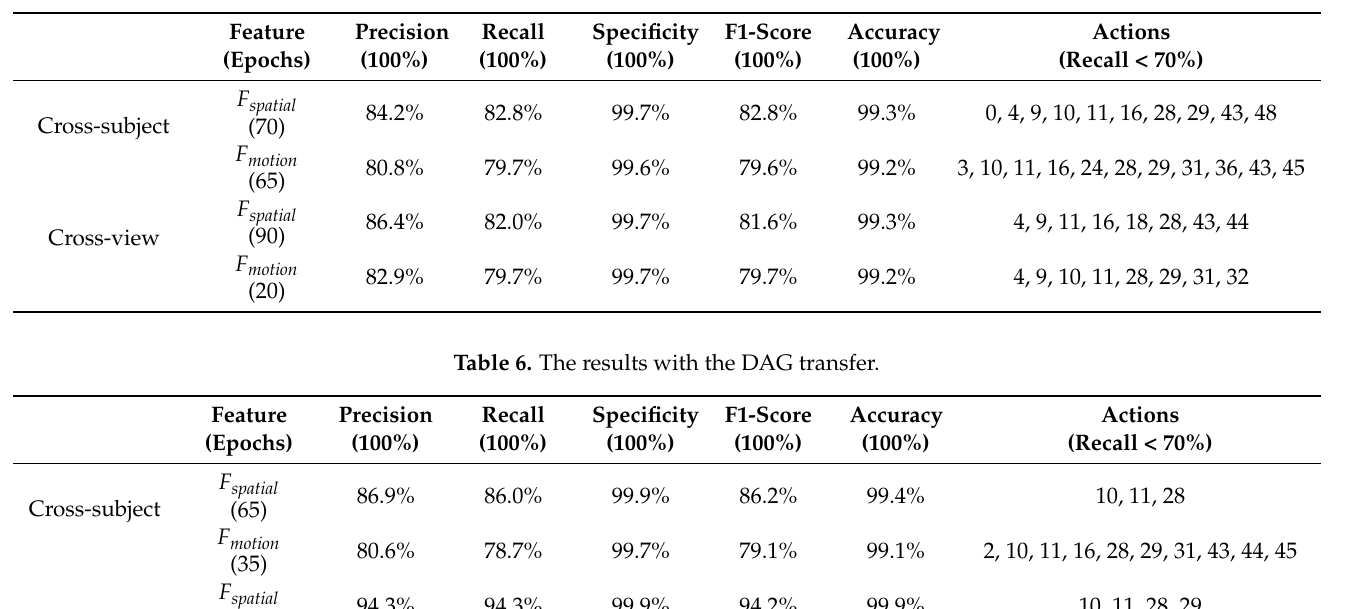
Table 5. The results without the DAG transfer.